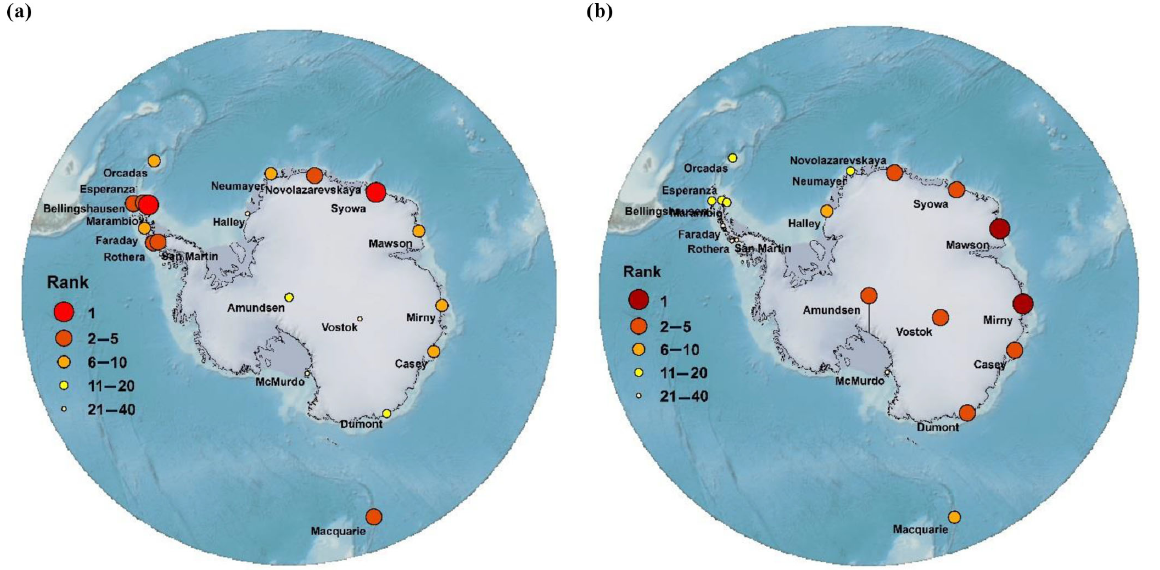
Figure 6. Ranking of the monthly mean temperature at observation stations: (a) October 2016 and (b) November 2016. The number “1” means the warmest month since 1981, number “2” signifies the second warmest, etc. The analyzed period is 1981–2016.